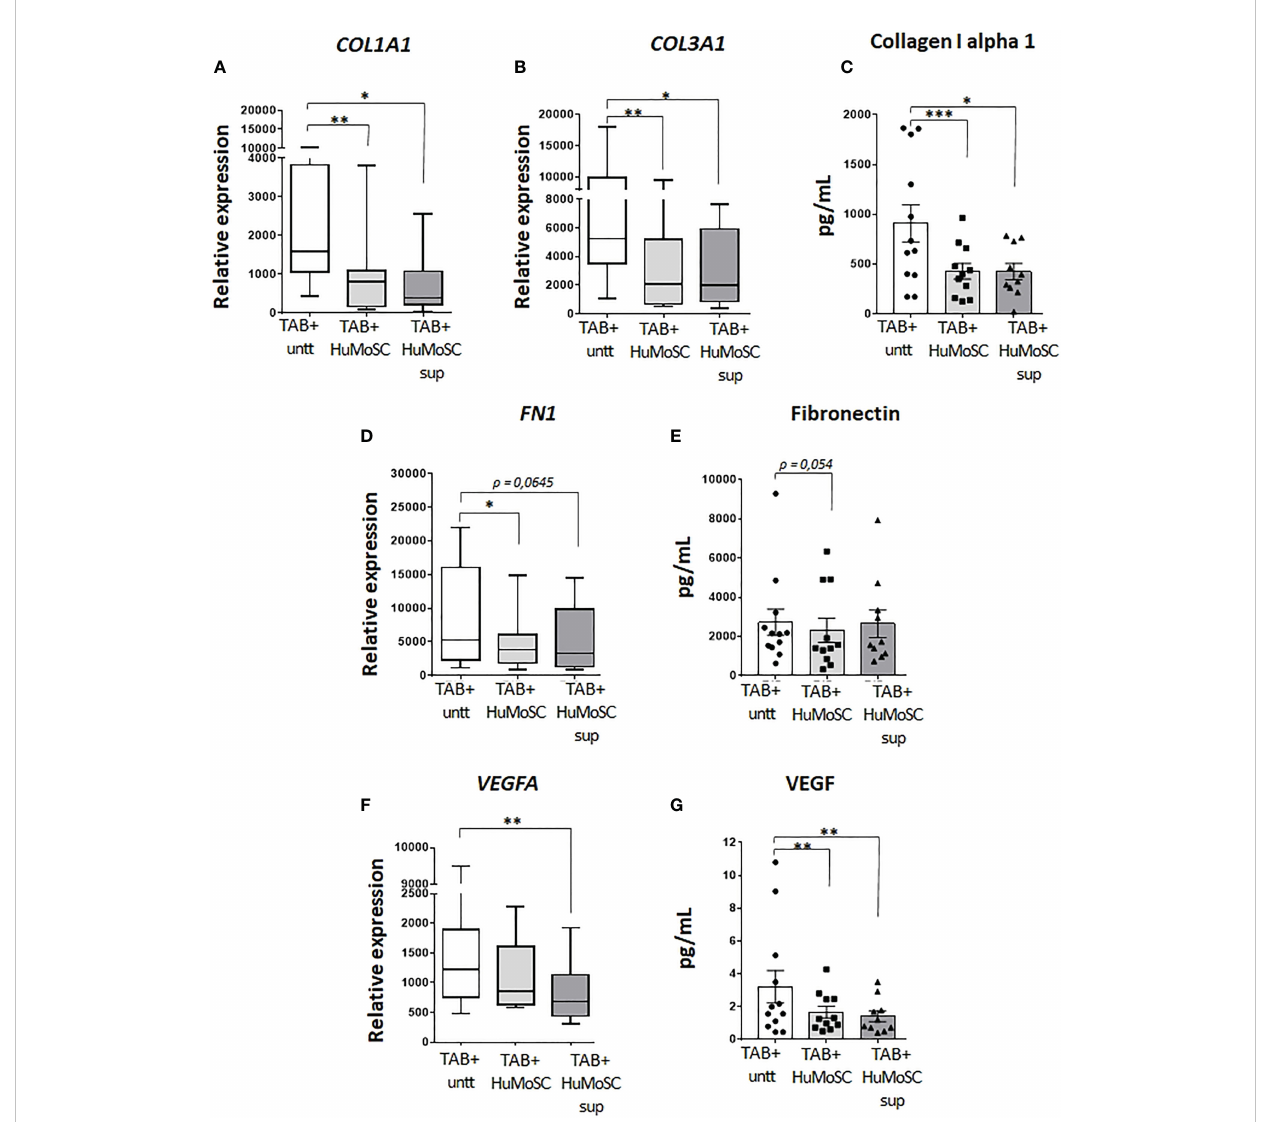
FIGURE 2 Effect of HuMoSC on vascular remodelling. Sections of fresh temporal arteries (TABs) affected by GCA (TAB+) were embedded in MATRIGEL. At day 1, HuMoSC (250.10 3 cells/mL) or 25% of HuMoSC supernatant was added. Each condition was performed in duplicate. After 5 days of culture, arterial sections were collected to measure mRNA by RT-PCR and the supernatant was used to measure proteins. (A-E) effect of HuMoSC on the production of matrix proteins: mRNA expression in TAB+ (A, B, D) and protein level in the supernatant (C, E) . (F, G) effect of HuMoSC on angiogenesis: mRNA expression of VEGFA in TAB+ (F) and concentration of VEGF in the supernatant of culture (G) . Experimental conditions: untreated TAB+ (n=12), TAB+ treated with HuMoSC (n=11) or of HuMoSC supernatant (n=10). Whisker boxes show the median (horizontal bar), the IQR (limits of the box) and extreme values (error bars). Histograms show the median (horizontal bar) and the IQR (error bars). P is the result of Wilcoxon tests. Signi fi cant results are shown ( *P < 0.05, **P < 0.01 and ***P < 0.001) otherwise non-signi fi